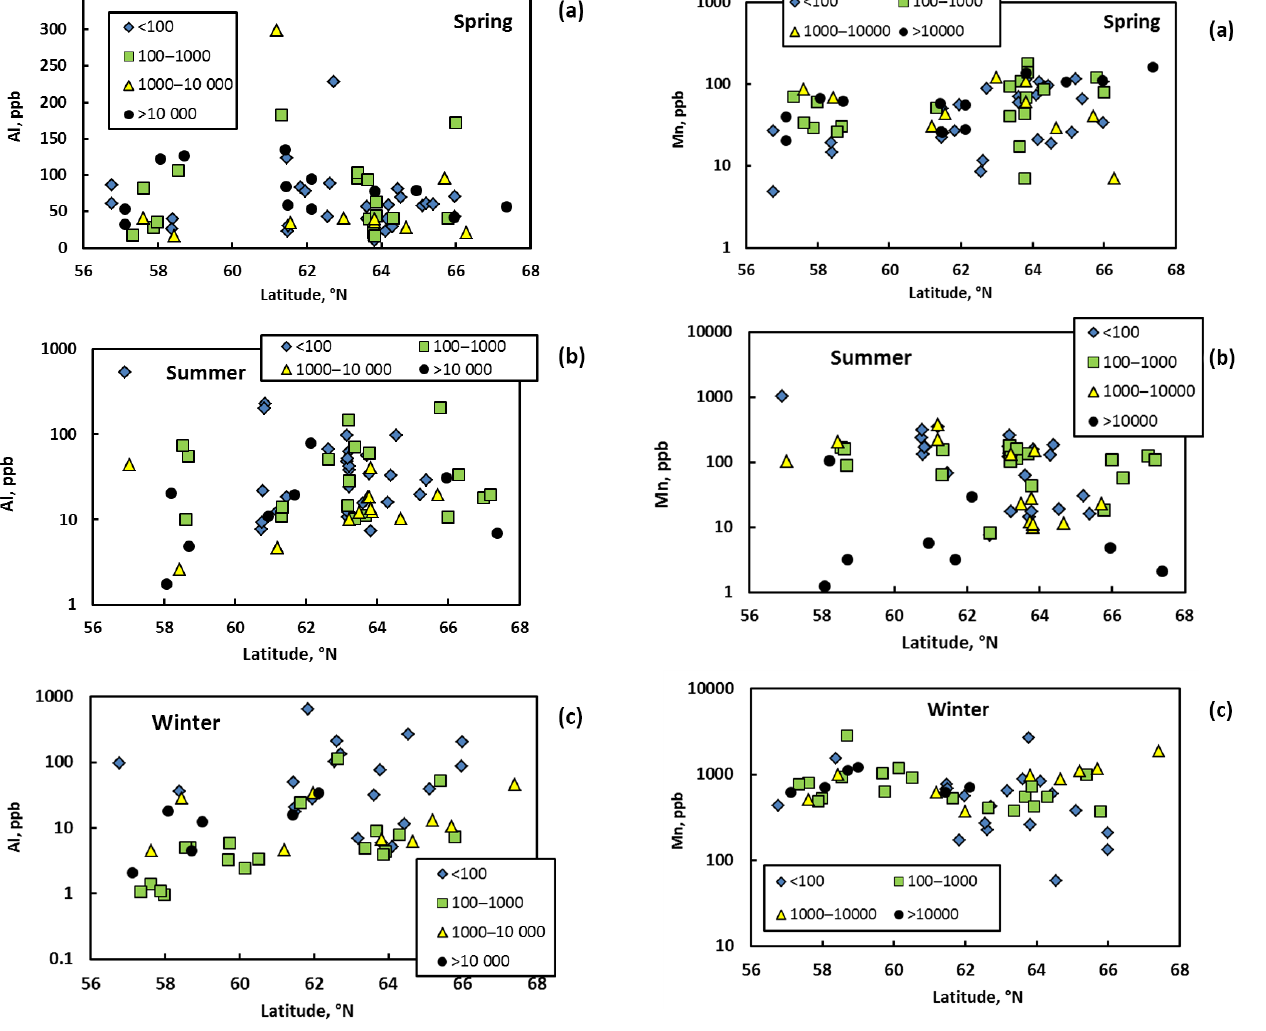
Figure 3. Variation in Al concentration with latitude during spring (a) and summer (b) and an increase in Al concentration north- ward in winter (c) . The latitudinal trend in winter is significant at p <0.05. Considering all seasons together, the differences between different watershed sizes are not statistically significant ( p >0.05). The symbols are the same as in Fig. 2.